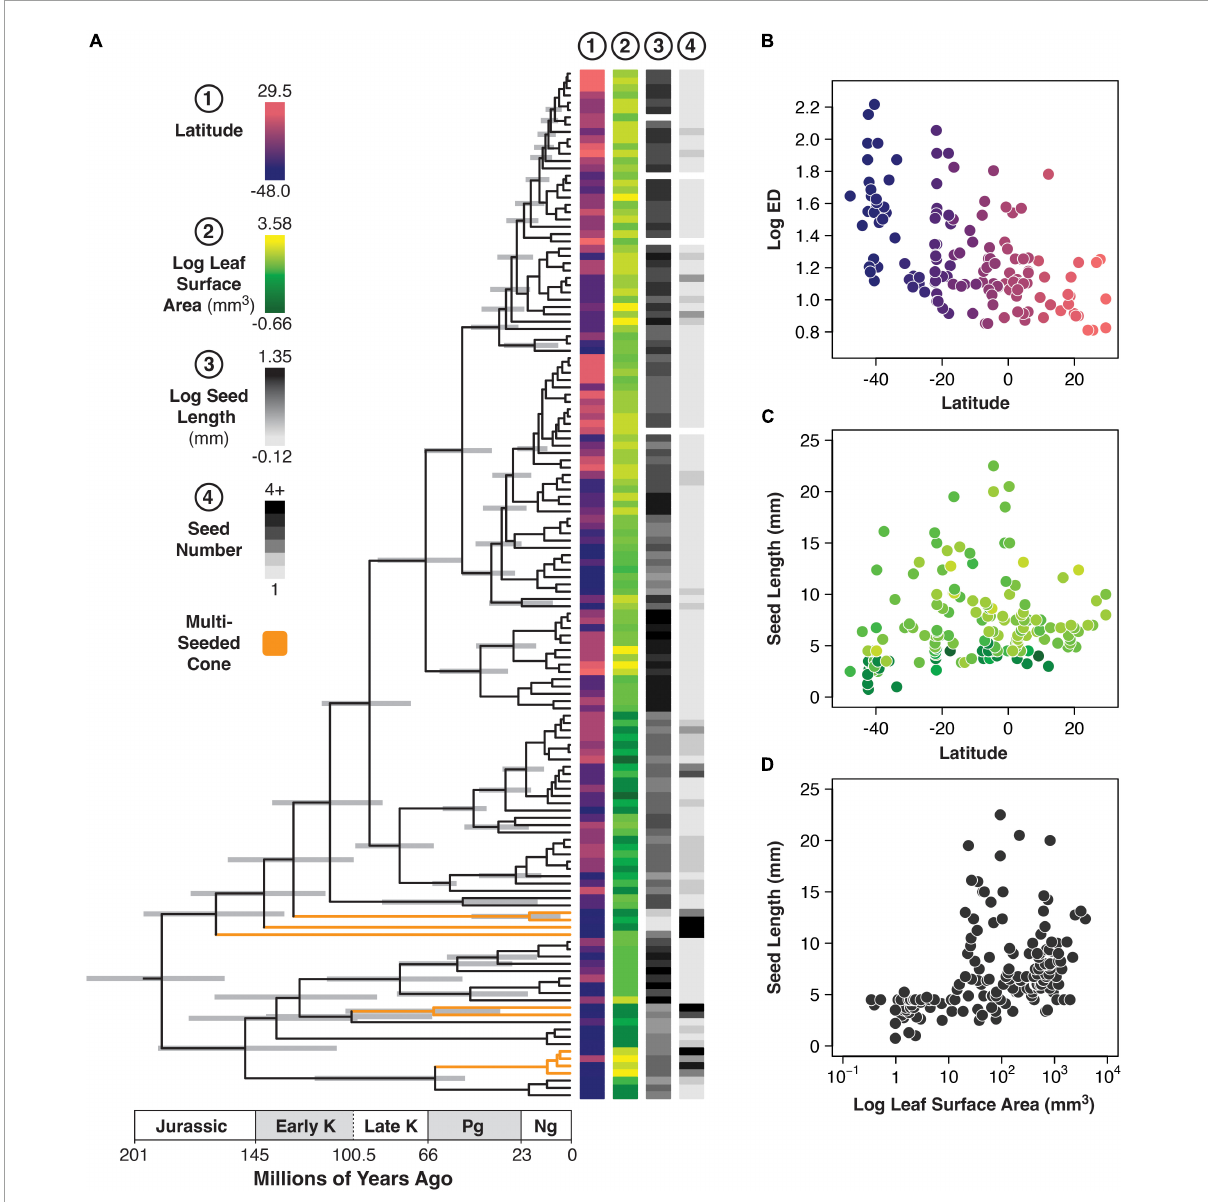
FIGURE2 Phylogenetic distribution and relationships of selected Podocarpaceae traits. (A) Time-calibrated molecular phylogeny of extant Podocarpaceae plotted with midpoint species latitude (1), log 10 -transformed estimated leaf area (2), log 10 -transformed seed length (3), and seed number per reproductive structure (4). Taxa lacking information for seed length and number are shown as white breaks in the data column. Phylogeny is taken from Leslie et al. (2018) and errors on estimated divergence ages [95% height posterior distributions (HPD)] are shown as gray bars. (B) Relationship between species latitude and log 10 -transformed evolutionary distinctiveness (ED); points are color coded by latitude as in panel (A) to facilitate comparison with the phylogeny. (C) Relationship between species latitude and seed length; points are color coded by leaf area as in panel (A) . (D) Relationship between log 10 -transformed leaf area and seed